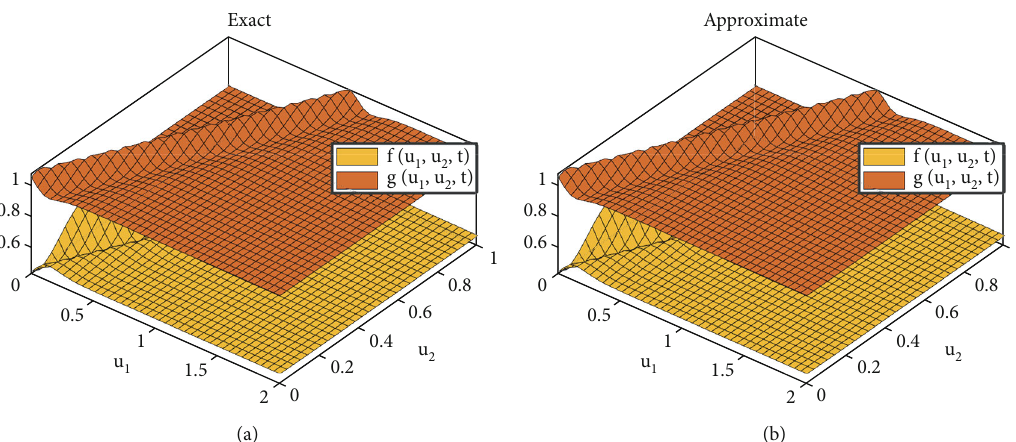
Figure 5: 3D comparison view of the exact and approximate solution of Example 16 when δ